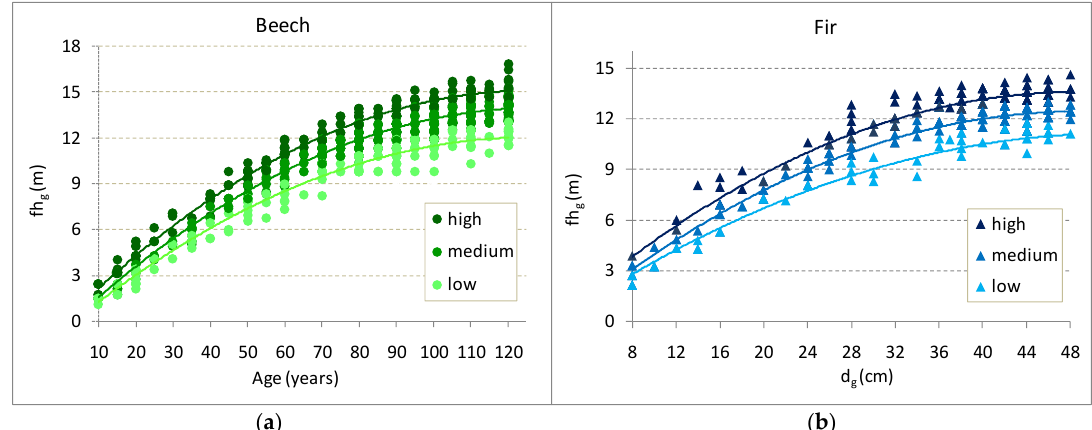
Figure 4. Relationship between form height ( fh g ) and age in beech ( a ) and between form height ( fh g ) and diameter in fir ( b ).